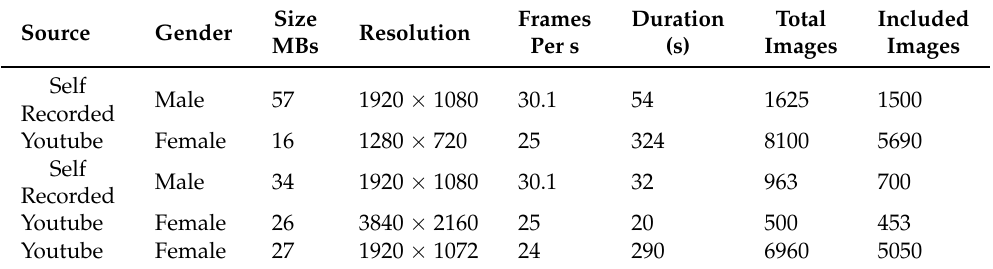
Table 1. Details of dataset